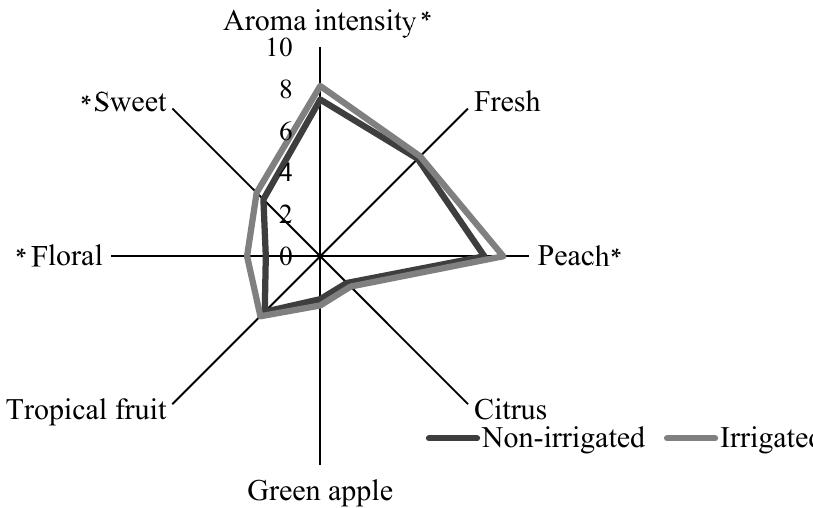
Figure 2. Mean scores of aroma sensory profile of Chelva wines made with grapes from irrigated and non-irrigated vines. * Statistical differences at the 0.05 level according to the